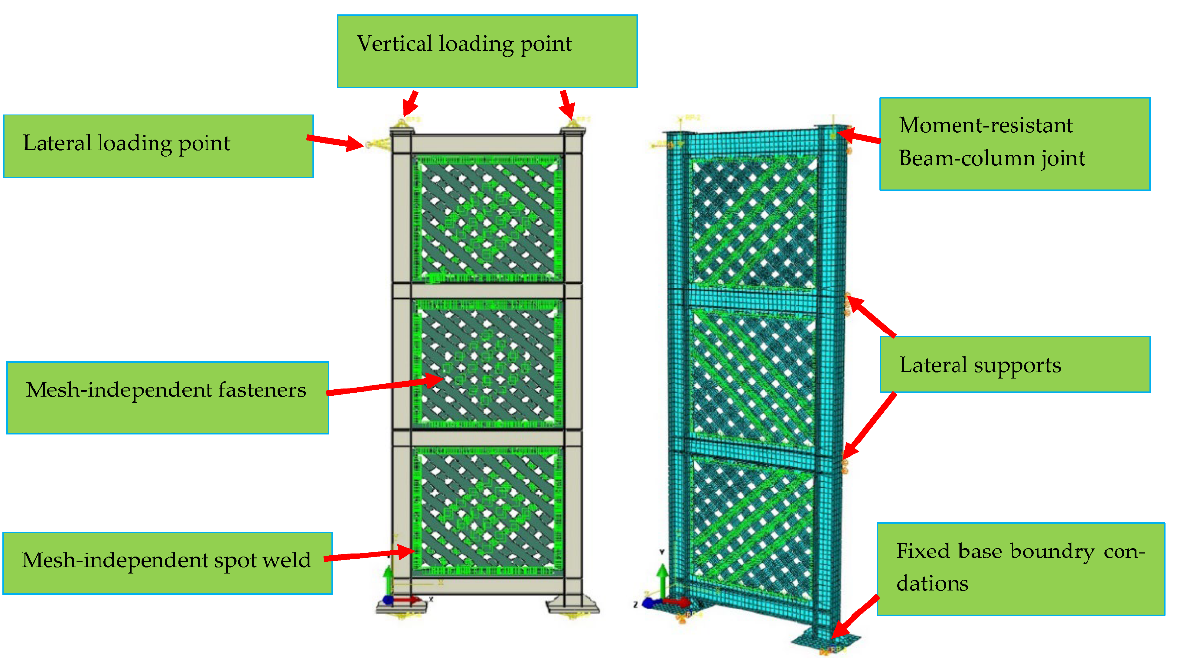
Figure 13. The developed FE model of the IWS-SPSW specimen.